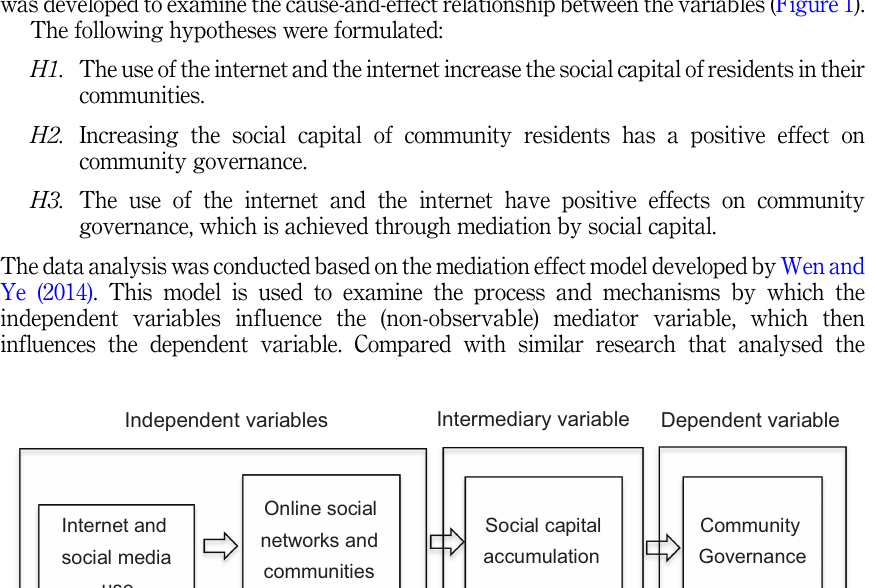
Figure 1. The research design and